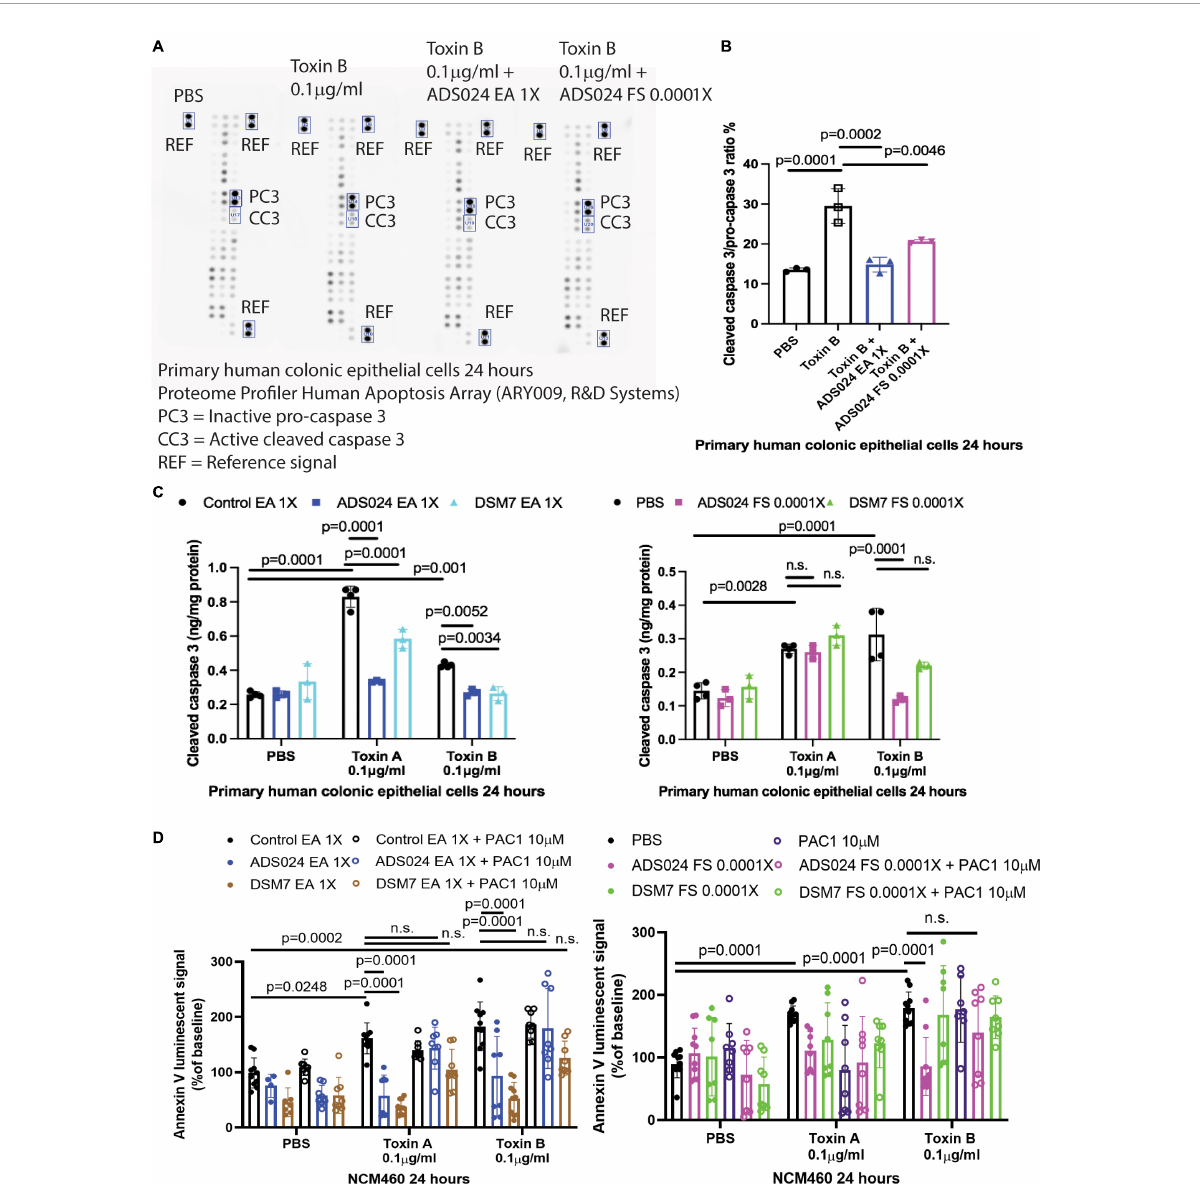
FIGURE6 ADS024 inhibited caspase three cleavage in toxin-treated human colonic epithelial cells. (A,B) Apoptosis array. Serum-starved primary human colonic epithelial cells were pretreated with ADS024 ethyl acetate extract at 1X or sterile filtrate at 0.0001X dilution for 30 min, followed by toxin B (0.1 µ g/ml). A total of 24 h later, the cells were collected for Proteome Profiler Human Apoptosis Array (ARY009, R&D Systems). (A) Bio-Rad ChemiDoc Imaging system captured the images. The rectangles highlighted the inactive procaspase three and active cleaved caspase three. The images are representative of three independent experiments. (B) Bio-Rad Image Lab Software performed quantitation of cleaved caspase 3/procaspase 3 signal. Toxin B increased cleaved caspase 3/pro-caspase 3 ratio, which was reduced by ADS024 EA extract 1X and sterile filtrate 0.0001X dilution. (C) Cleaved caspase 3 ELISA. Serum-starved primary human colonic epithelial cells were pretreated with ethyl acetate extracts of ADS024 and DSM7 at 1X or sterile filtrates of ADS024 and DSM7 at 0.0001X dilution for 30 min, followed by the addition of toxin B (0.1 µ g/ml). The cells were lysed by RIPA buffer with 1X PIC and 1X EDTA. The cleaved caspase three levels in cell lysates were measured by ELISA. (D) Apoptosis assays. Serum-starved NCM460 cells were pretreated with ethyl acetate extracts of ADS024 and DSM7 at 1X and sterile filtrates of ADS024 and DSM7 at 0.0001X dilution with or without adding 10 µ M procaspase activating compound 1 or PAC1 (#10009317, Cayman Chemical). PAC1 was used to activate caspase three cleavage. Reagents of Promega RealTime-Glo Annexin V apoptosis assay in a 1:1,000 ratio were added simultaneously. Thirty minutes later, toxin A or toxin B (0.1 µ g/ml) was added to start the apoptosis process. After 24 h, the luminescent (apoptosis) signals were read by a 96-plate reader. The Annexin V luminescent signal above 100% indicated the occurrence of apoptosis. The ADS024 EA extract-mediated inhibition of toxin A- and B-dependent apoptosis was reversed by PAC1 pretreatment. The ADS024 sterile filtrate-mediated inhibition of apoptosis in toxin B-treated cells was reversed by PAC1 pretreatment. Results were pooled from 3–4 independent experiments. One-way ANOVA tests were